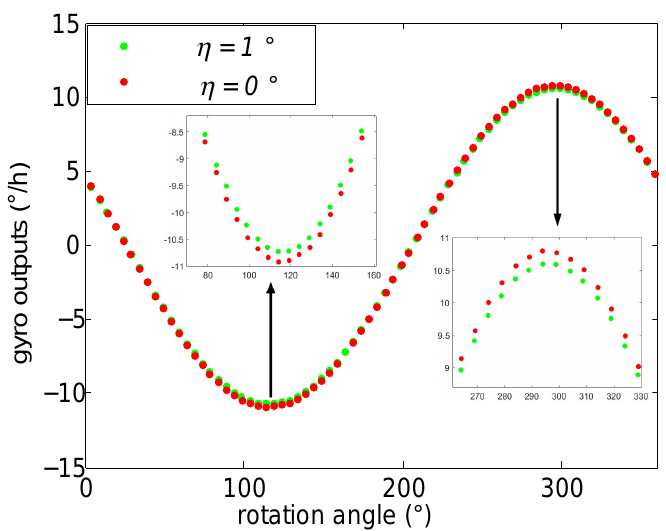
Figure 9. Comparison of the gyro outputs when the shaft is misaligned and aligned.